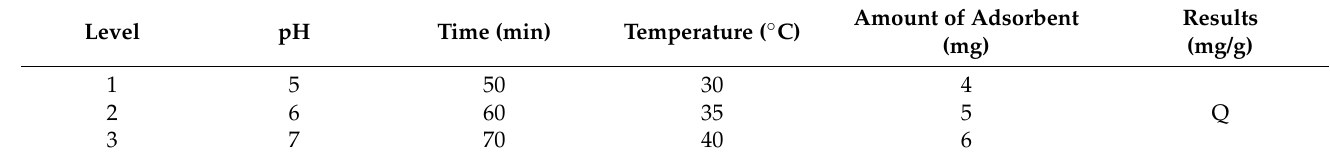
Table 1. Selection of experimental factor level conditions.